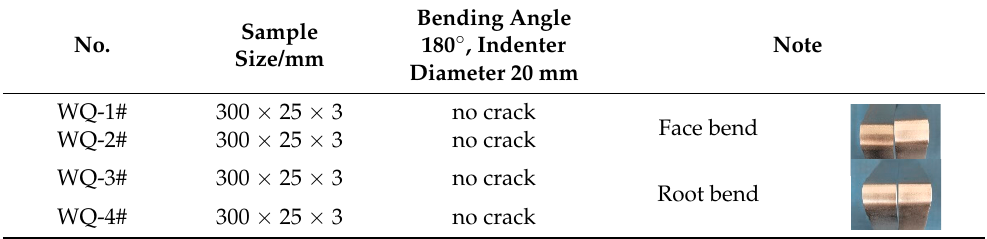
Table 5. The result of the bending tests.